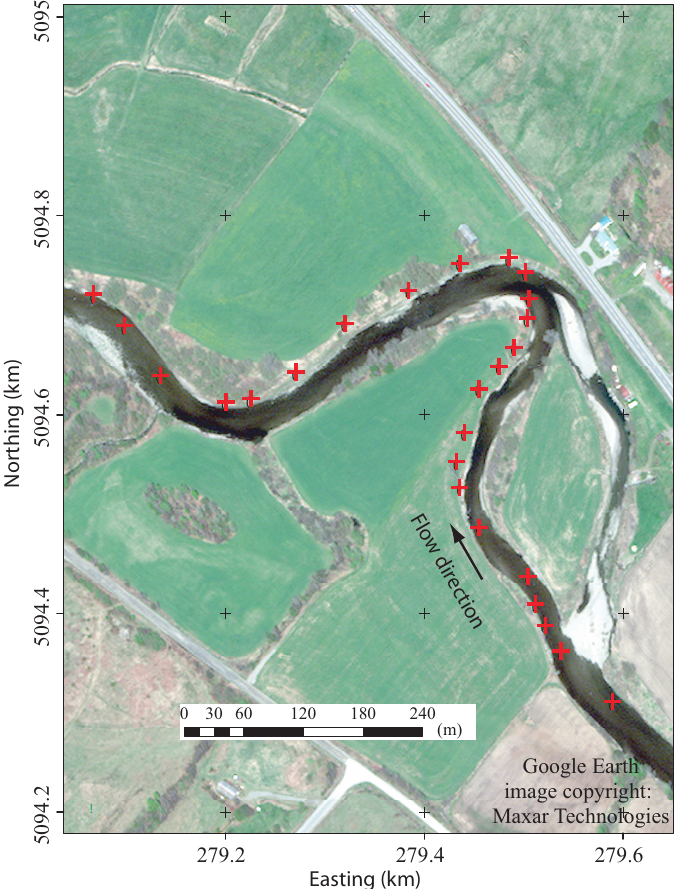
Figure 4. River path (red plus sign) extracted from a Google Earth image captured on 20 May 2016, overlaid on the WV-3 image. The ground coordinates of the WV-3 pixels were geo-referenced using the 2014 USGS DEMs. For clarity, only a portion of the 26 km river section is